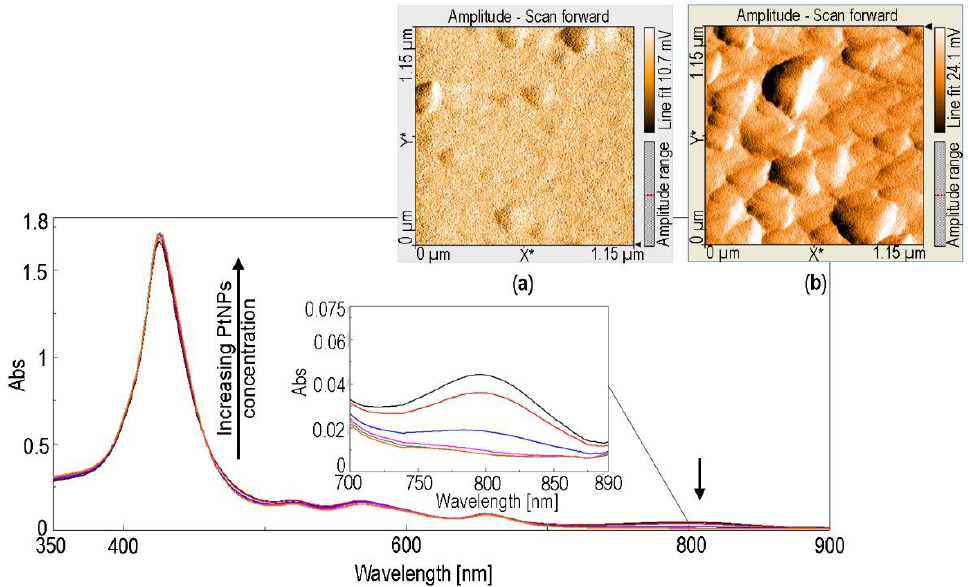
Figure 8. Overlapped UV-Vis spectra, monitoring the obtaining of TAmPP- PtNPs hybrid material. Detail ( a ): AFM image of TAmPP- PtNPs hybrid material. Detail ( b ): AFM image of TAmPP.